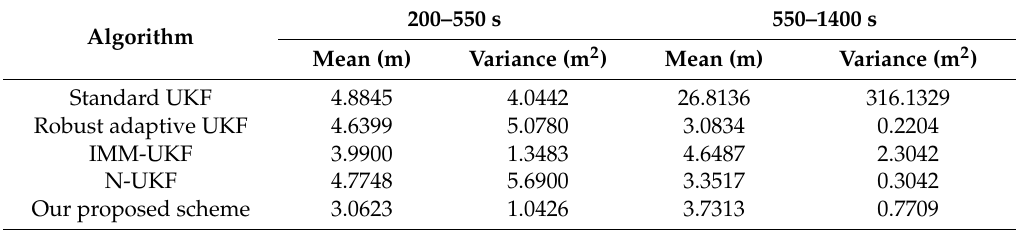
Table 3. Position errors of the different schemes for Case